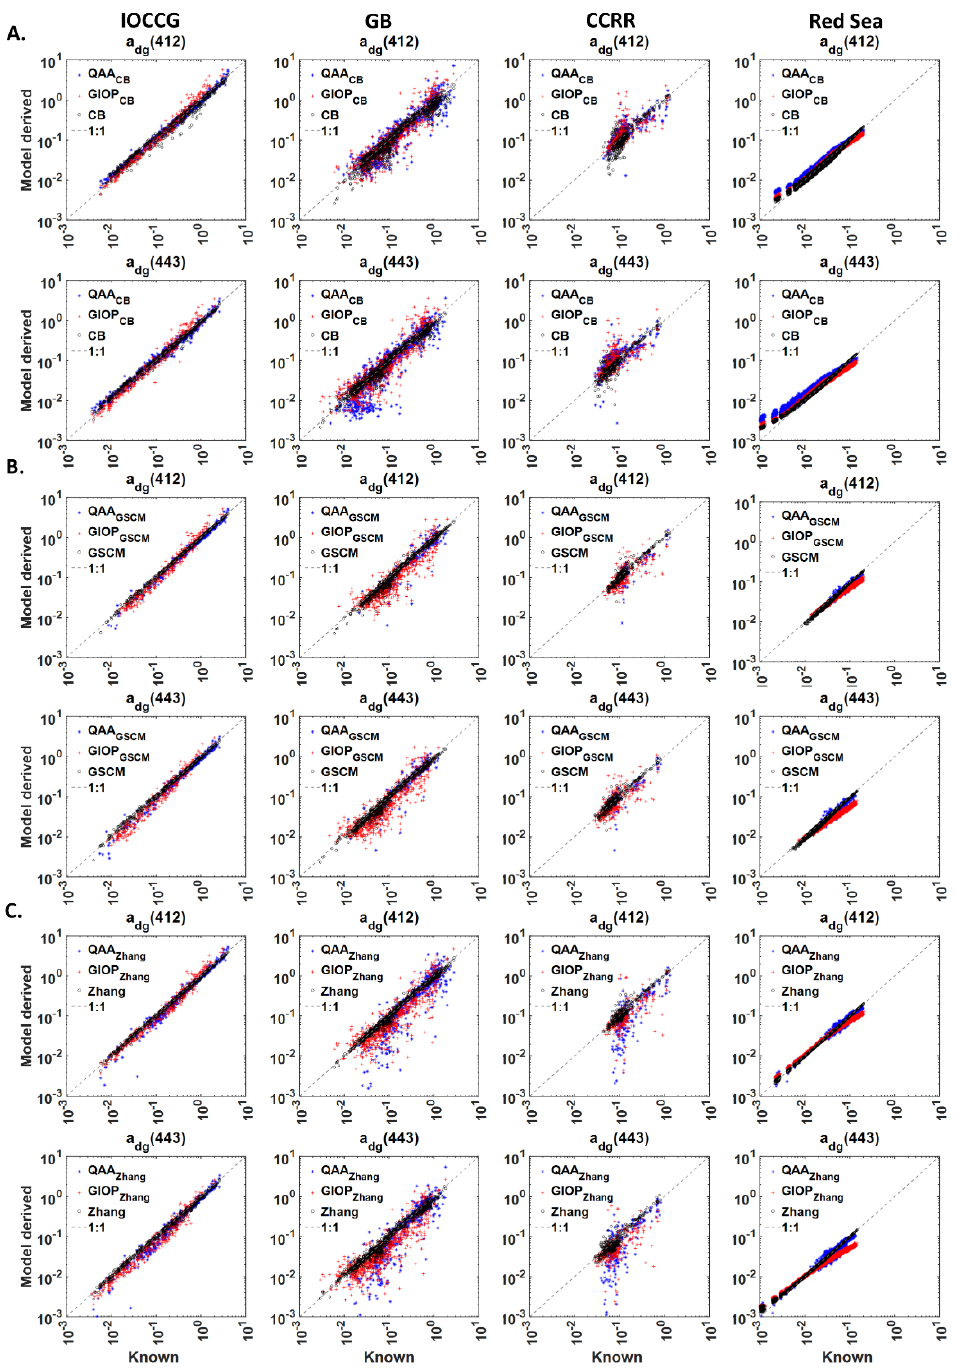
Figure 9. Comparison of model-derived and known (measured or synthetic) values of the phytoplankton absorption coefficient, a dg from ( A ). GIOP CB , QAA CB and CB models at 443 and 510 nm, ( B ). GIOP GSCM , QAA GSCM and GSCM models at 443 and 670 nm, ( C ). QAA Zhang , GIOP Zhang and Zhang’s models at 443 and 670 nm. The hybrid models QAA CB , QAA GSCM , QAA Zhang , GIOP CB , GIOP GSCM and GIOP Zhang models use R rs (λ) , spectral remote sensing reflectance to derive absorption subcomponents. Blue dots and red plus indicate the hybrid models that use GIOP and QAA in the first step. The absorption decomposition algorithms, CB, GSCM and Zhang’s (Black circles) models, use a nw (λ) , spectral non-water absorption coefficient to derive the absorption subcomponents, λ is the wavelength. The inputs for the models, i.e., R rs (λ) and a nw (λ) are taken from the four datasets, IOCCG, GB, CCRR and the Red Sea. The 1:1 relationship is shown in a grey dotted